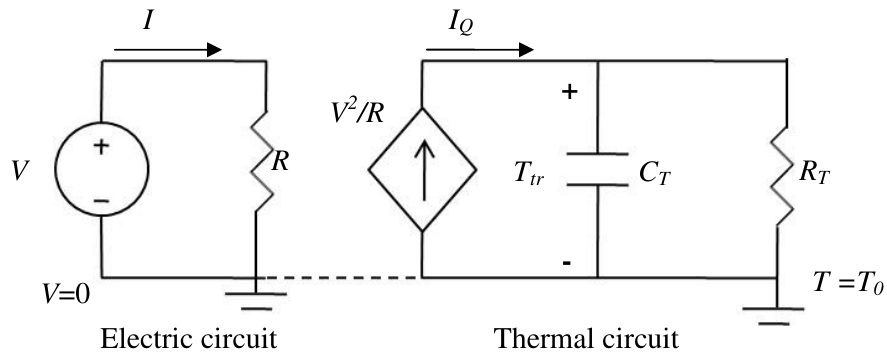
Figure 5. Circuit model for the self heating of a resistor driven by a voltage